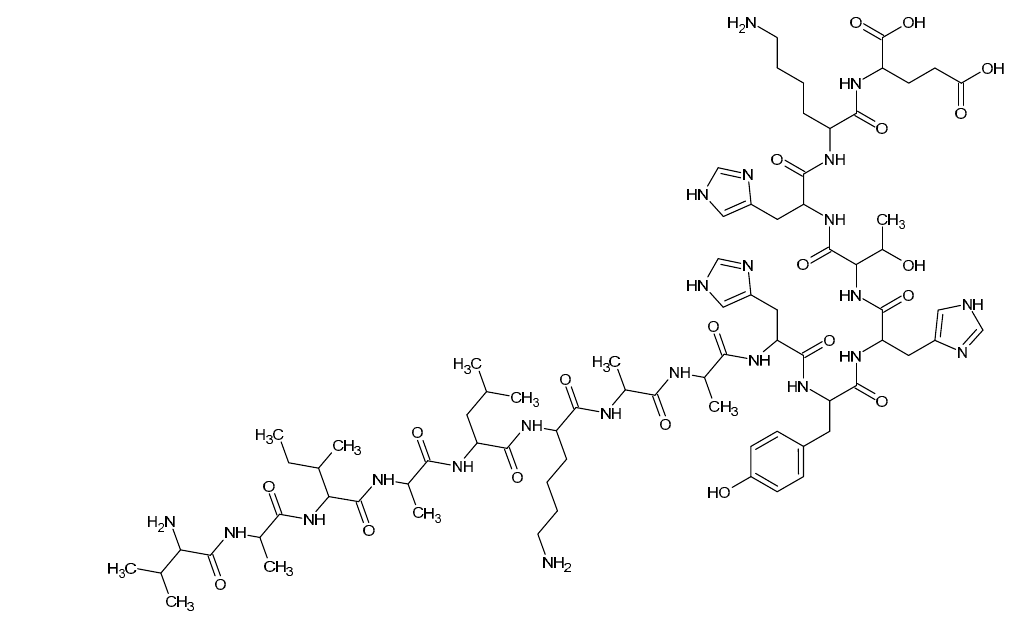
Figure 1. Primary structure of Cal (VAIALKAAHYHTHKE).